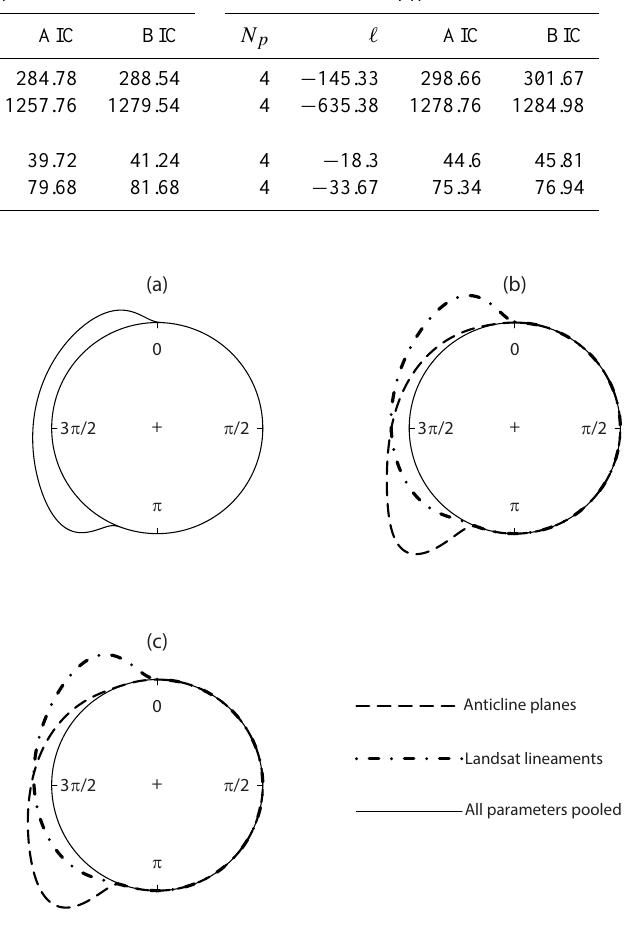
Figure 3. Density of projected normal distributions fitted to com- bined Bangladesh data and wrapped around the circle. (a) Model 1, with all parameters pooled for the combined data set; (b) Model 2, with µ modelled separately for anticline axial planes and Landsat lineaments; (c) Model 3, with all parameters separate for anticline axial planes and Landsat